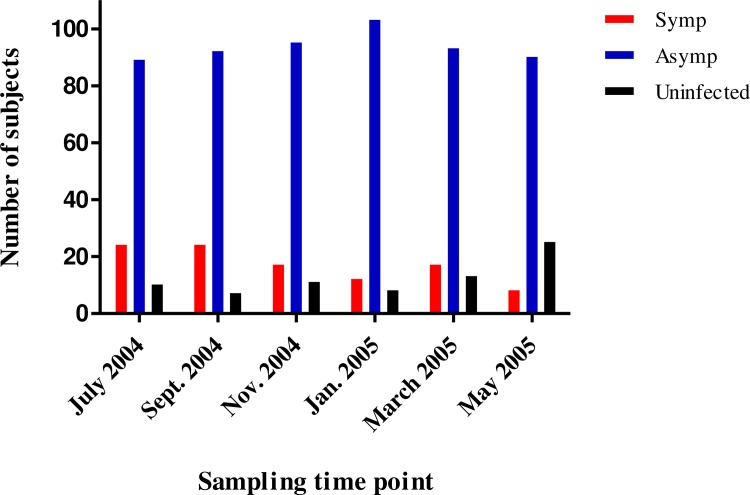
Numbers of symptomatic and asymptomatic children at the six sampling time points.At each sampling time point (from July 2004 to May 2005), the 126 children were grouped into three categories; children with clinical malaria (blood film parasitaemia, fever and at least one other symptom of malaria and no other obvious cause for the fever, described as Symp), children with blood film parasitaemia but no clinical symptoms (Asymp) and children with no blood film parasites (Uninfected).